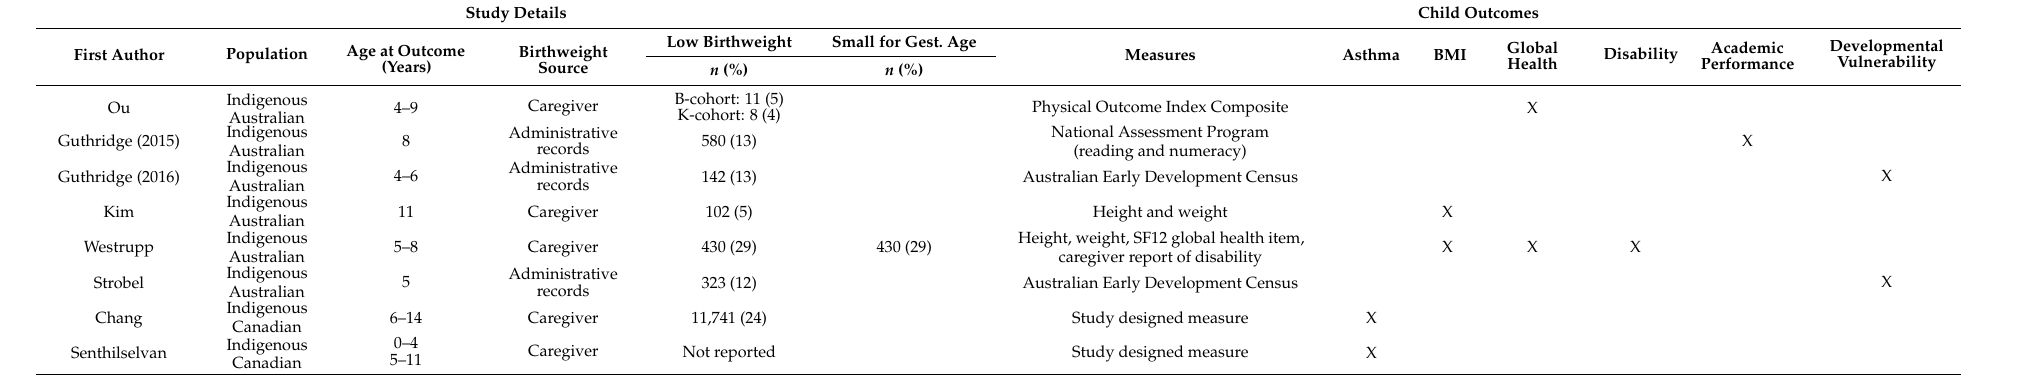
Table 2. Classification of birthweight and size and child health outcomes reported in each paper ( n =